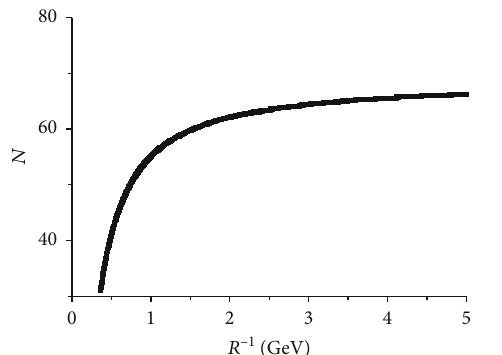
Figure 1: The number of e -folds N for the intermediate scenario as a function of the R − 1 for R _ R = 0 : 1 , A = 1 , and f = 1/2